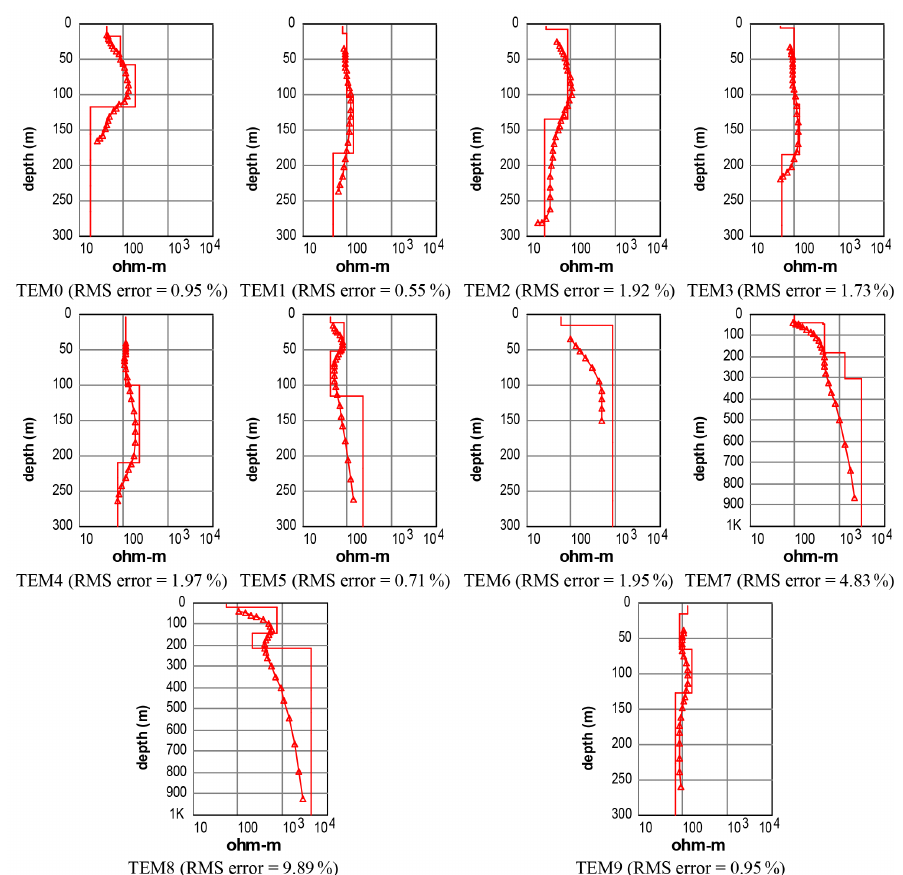
Figure 12. Apparent resistivity with depth. The red triangles connected by the red line represent the measured apparent resistivity values, and the red line without triangles represents the inverted 1-D geoelectric model. Table 4. TEM-derived depth of river deposits bottom in the east. Name